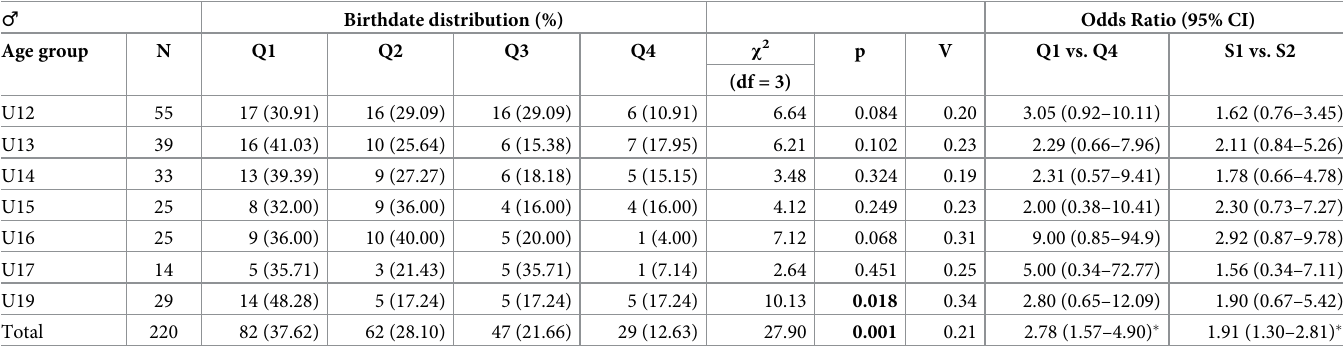
Table 3. Relative age effect analyses across Luxembourgish national